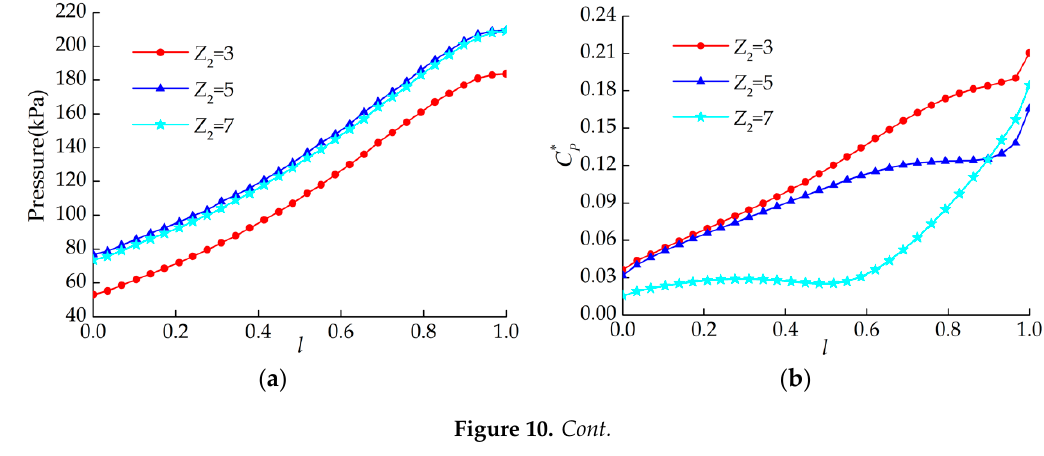
Table 6. Correlations between the number of guide vanes and hydraulic and hydroacoustic characteristics of the impeller.